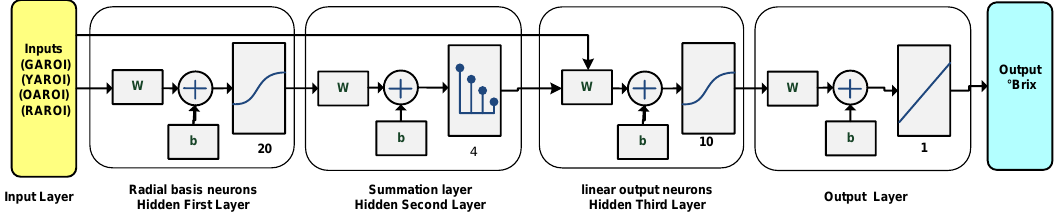
Figure 7. Brix prediction Artificial neural networks (ANN) model.